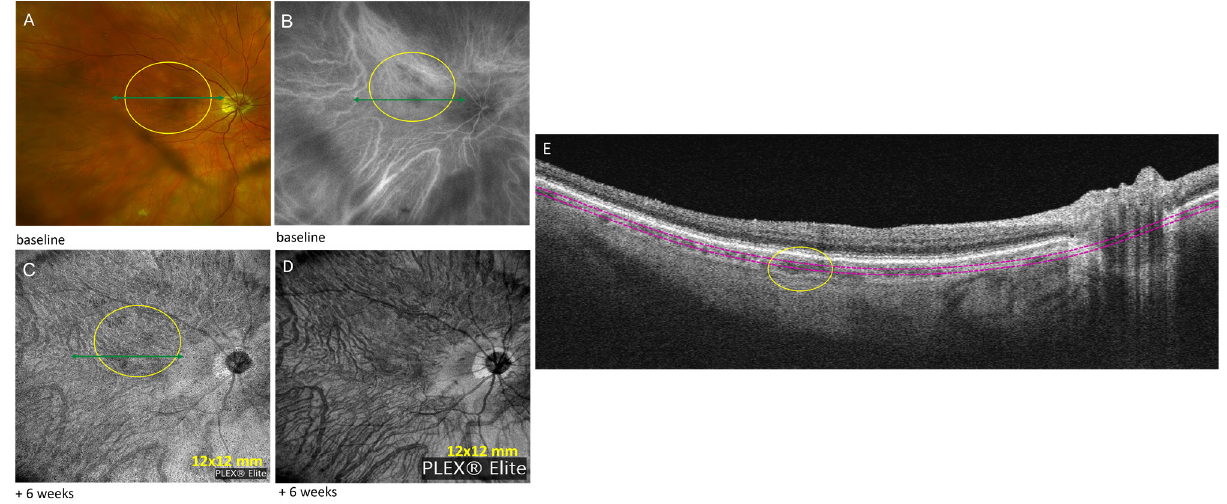
Figure 2. Case 2: Sarcoidosis: Choroidal granuloma. ( A ) Color fundus photograph shows multiple sarcoid choroidal granulomas that appear as deep choroidal lesions in the posterior pole (circle); ( B ) ICG angiogram shows corresponding lesions as hypofluorescent lesions (circle); ( C ) Zeiss PLEX ® Elite 9000 OCTA (12 mm × 12 mm) performed 6 weeks later showed the granulomas as areas of “non-detectable flow signal” in the corresponding inner choroid (circle). ( D ) On the en face structure, we do not see a shadow in the lesion. Green lines in ( A – C ) correspond to the position of the SD-OCT scan in E. ( E ) Choroidal granuloma occupying the full-thickness of the choroid on SD-OCT (circle). En face segmentation boundaries shown in magenta.